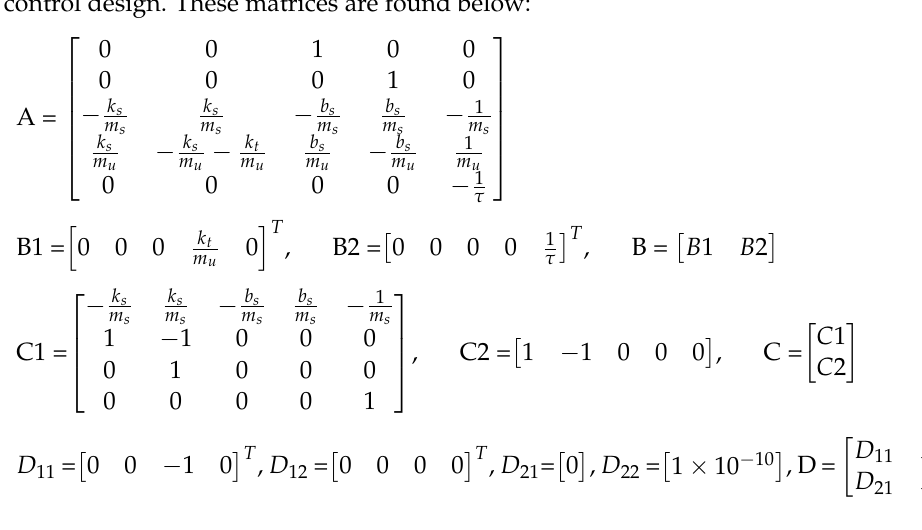
Table 1. Parameters of the suspension. Parameters Front Rear (Symbols) Suspension Suspension sprung mass ( m s